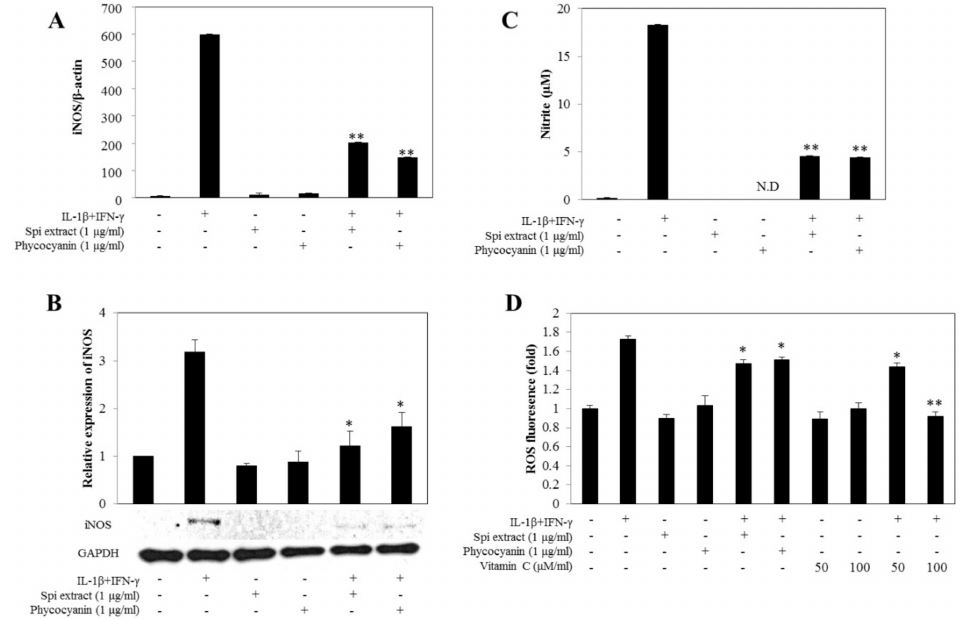
Figure 5. Spirulina extract inhibits cytokine-induced iNOS expression, NO production, and ROS generation. RINm5F cells were co-treated with Spirulina (Spi) extract or PC, and IL-1 β and IFN- γ for 24 h. ( A ) The iNOS mRNA expression level was determined using real-time PCR, and the housekeeping gene beta-actin was used to normalize the data; ( B ) Western blot analysis of iNOS. The relative expression levels of proteins were determined using SYNGENE Gel Image software and the control band was given an arbitrary value of 1; ( C ) NO production assayed by the Greiss method; ( D ) ROS generation detected by the fluorescence intensity CH-H2DCFDA. Each value represents the mean ± SEM of three independent experiments. The two-sample t -test was used to compare the results between the control group and treatment group. * p < 0.05, ** p < 0.01, significant difference between the Cytokine-treated and the Cytokine + Spi extract or Cytokine + PC